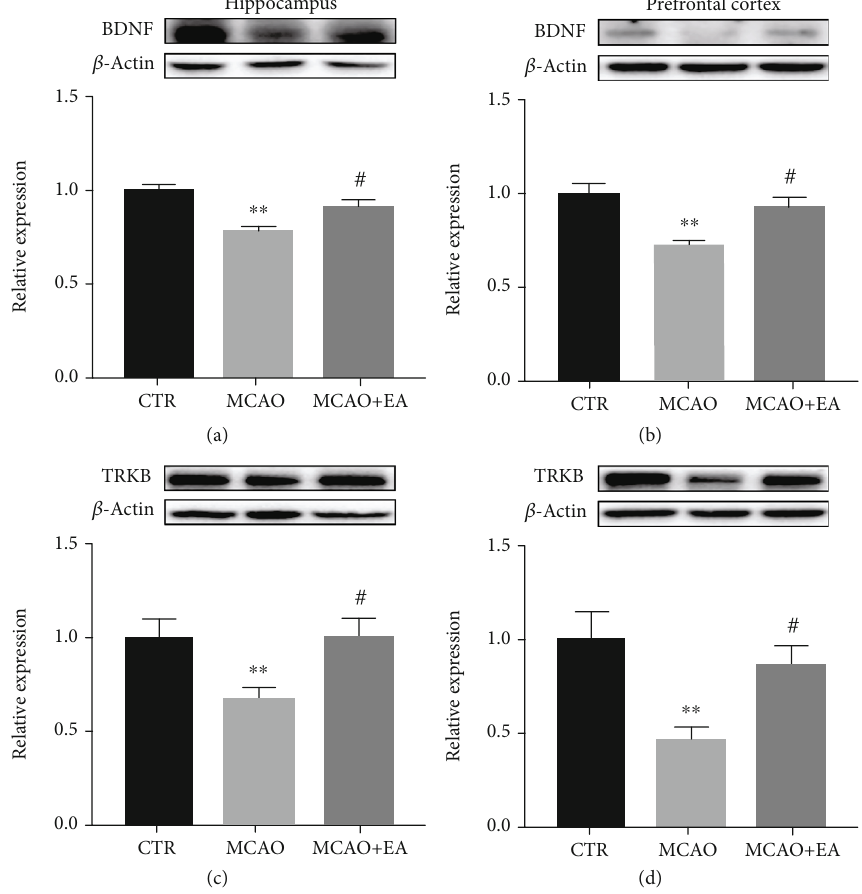
Figure 6: E ff ects of the MCAO and EA in neuroprotective-related proteins. BDNF (a, b) and TrkB (c, d) expressions in the hippocampus and PFC. Value is expressed as mean ± SEM , where ∗ p < 0 : 05 and ∗∗ p < 0 : 01 compared to control group and # p < 0 : 05 compared to the MCAO group ( n ≥ 5 each group). CTR: control; MCAO: middle cerebral artery occlusion; EA: